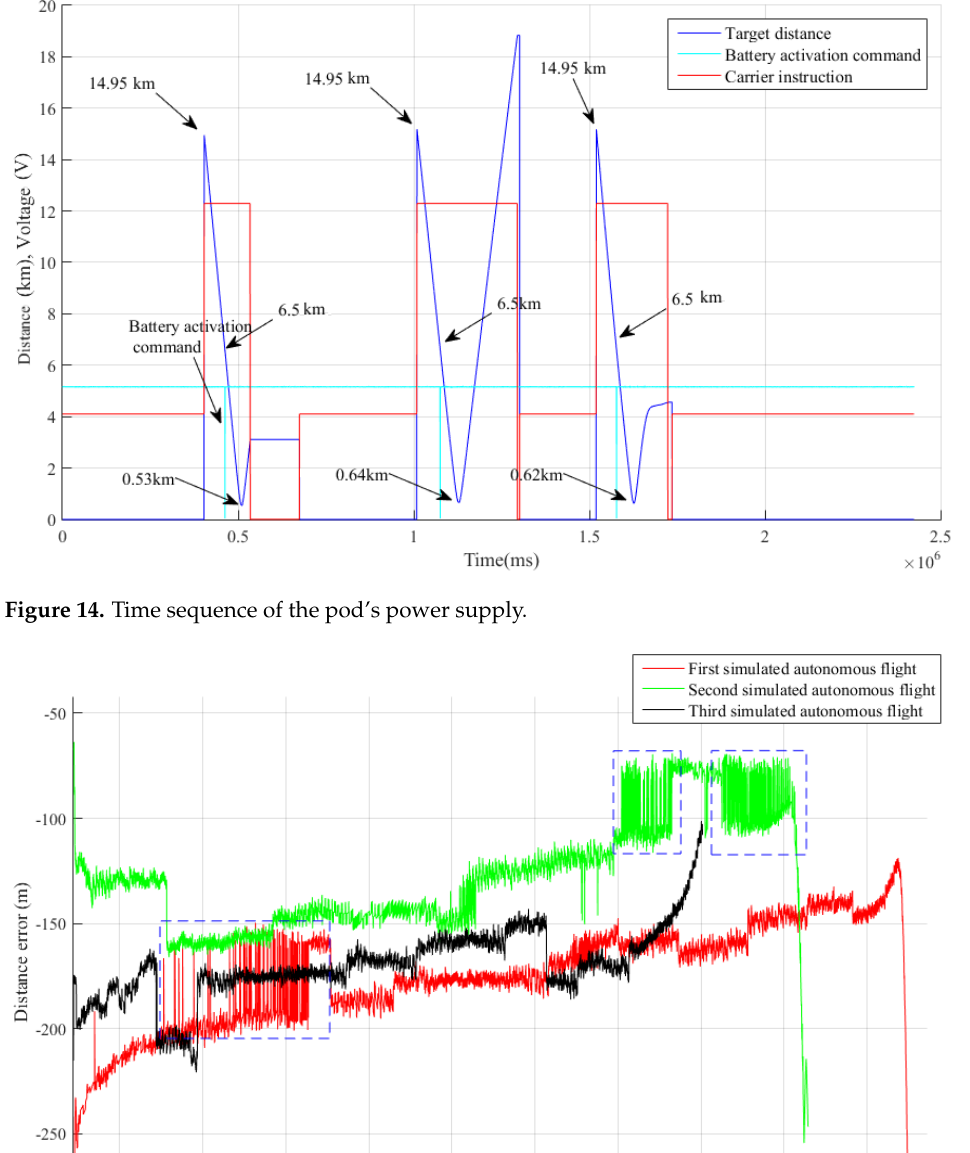
Figure 13. The pod’s power supply voltage.